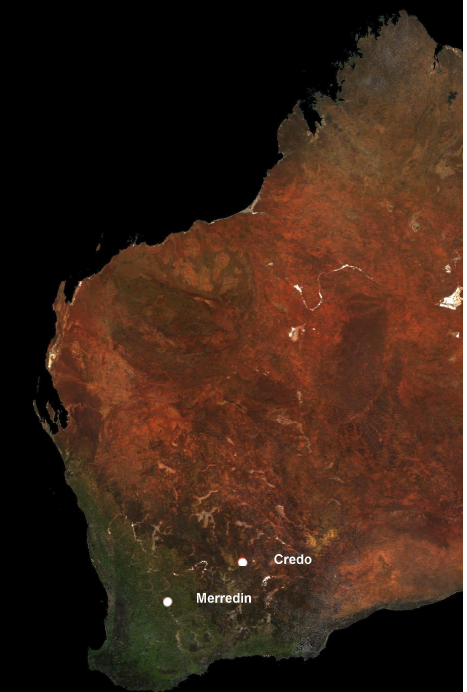
Figure 1. The location of the Merredin and Credo field sites.